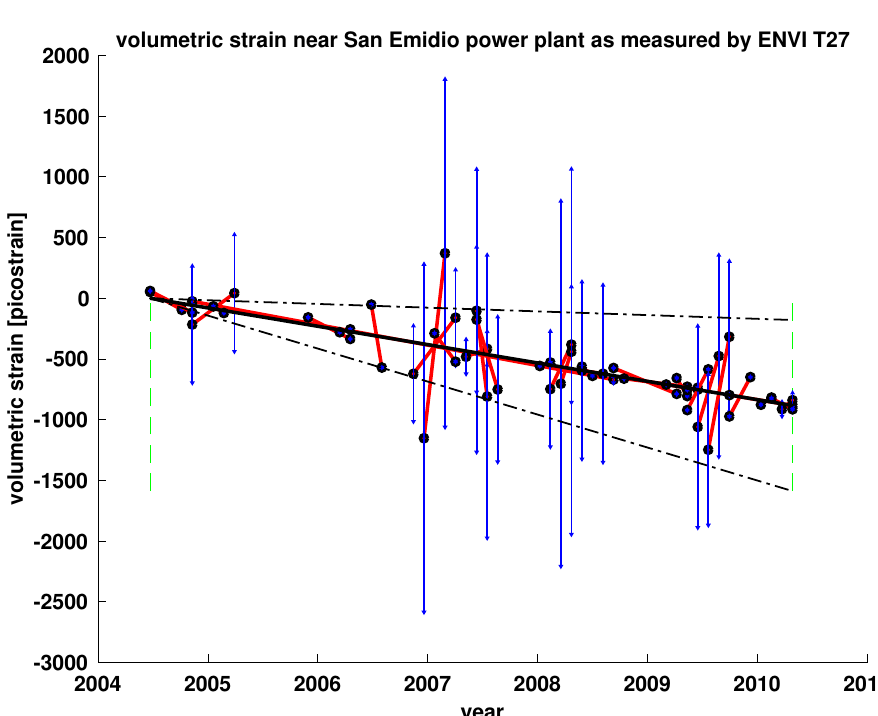
Figure A8. Cumulative strain near the San Emidio power plant as derived from temporal adjustment of mean strain rate values near the plant as measured by the ENVI T27 MST data set. Plotting conventions as in Figure